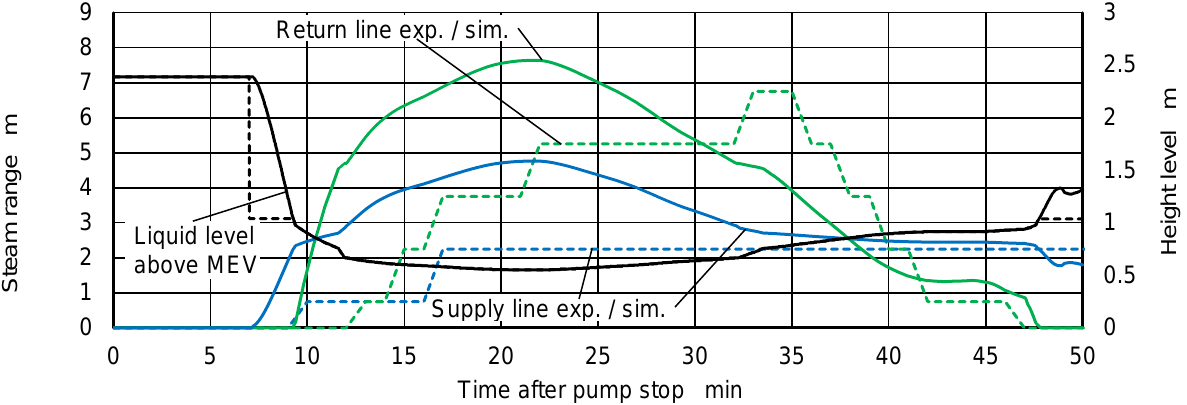
Figure 15. Steam range from experiment and simulation for the system with thermochromic absorbers. Active check valves. Dataset 07−25.